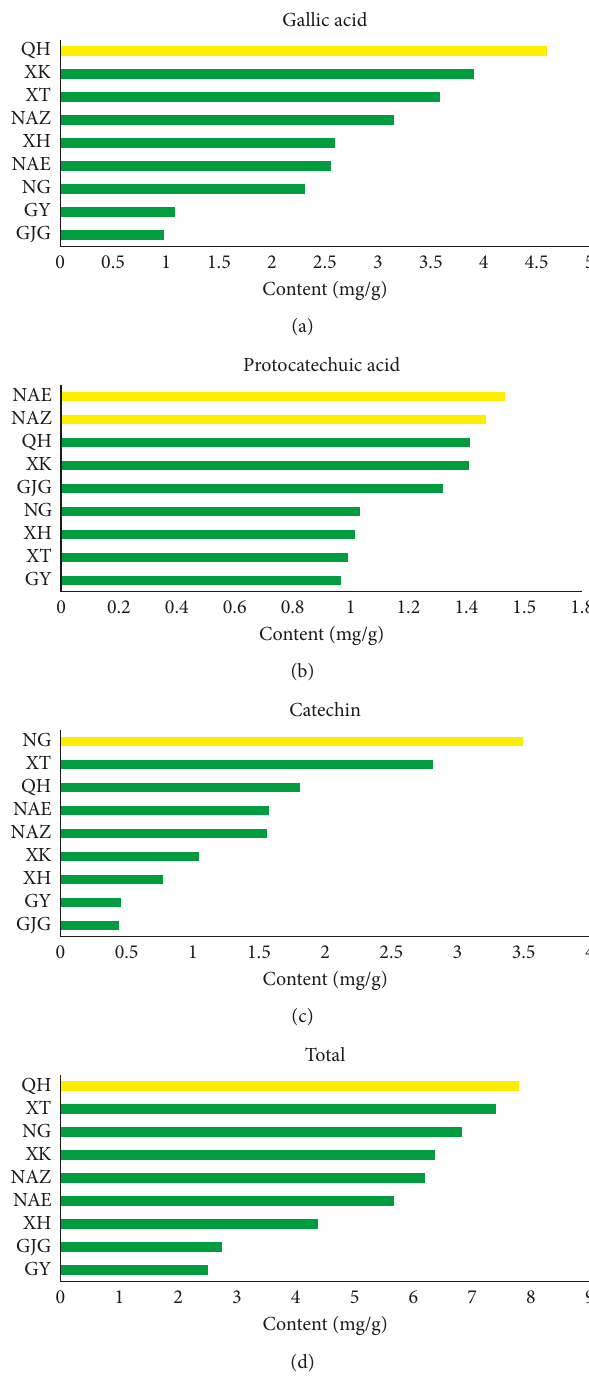
Figure 4: Comparison of content determination of C. songaricum between different producing areas from